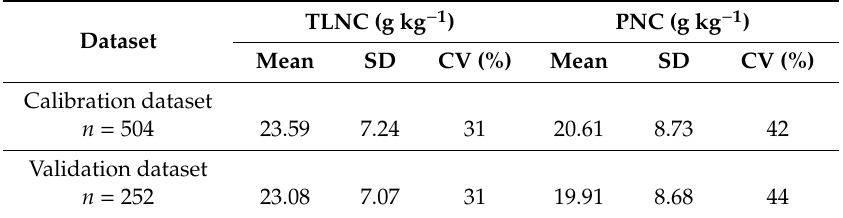
Table 3. Descriptive statistics for TLNC and PNC for calibration and validation datasets.